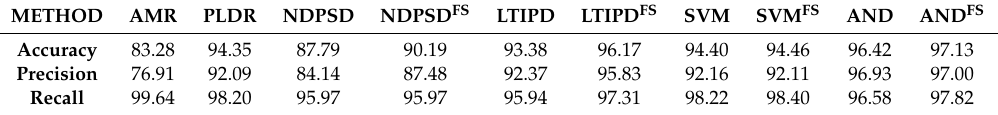
Figure 3. Receiver operating characteristics curves for various VADs with and without the proposed frequency selective approach for each signal-to-noise ratio (SNR). Table 1. Performance of accuracy, precision, and recall at the operating point minimizing E OVR